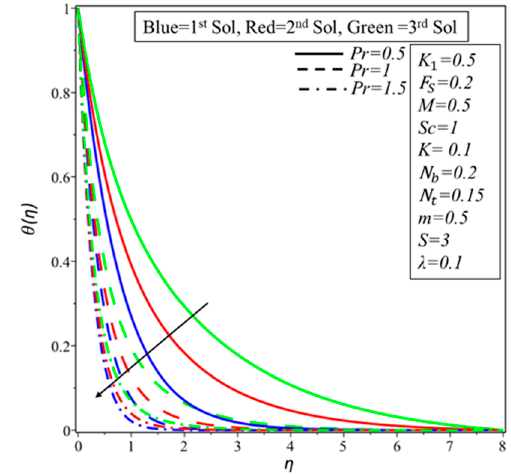
Figure 10. Temperature profiles for increasing values of Pr .